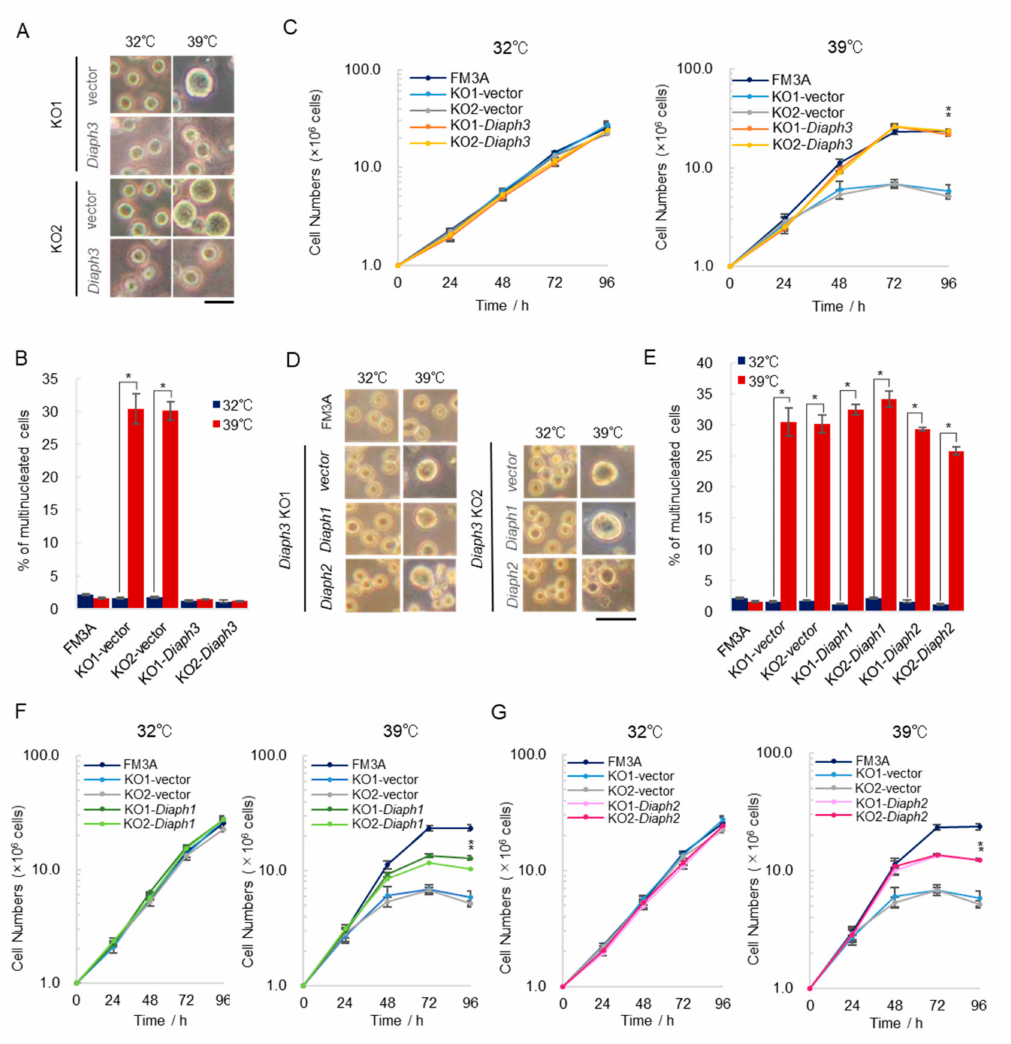
Figure 4. DIAPH3 is required for cell division only under high temperature conditions. ( A ) Cell images: Diaph3 KO1 and Diaph3 KO2 cells (KO1 and KO2) stably expressing Diaph3 were established and KO-vector and KO- Diaph3 cells were cultured for 96 h at 32 or 39 ◦ C under 5% CO 2 . The scale bar indicates 20 µ m. ( B ) Control Diaph3 -KO cells (KO-vector) and Diaph3 expressing Diaph3 -KO cells (KO- Diaph3 ) were cultured at 32 and 39 ◦ C for 24 h and were then subjected to DAPI staining. More than 300 cells were measured, and the percentage of multinucleated cells was calculated; (error bars: ± SEM); * p < 0.001 (Dunnett’s test); 32 vs. 39 ◦ C. ( C ) Growth curve analysis of KO-vector and KO- Diaph3 cells: Cells were seeded at 1.0 × 10 6 cells / dish and incubated at 32 or 39 ◦ C under 5 % CO 2 . Cells were collected every 24 h to determine the number of cells; (error bars: ± SEM); * p < 0.001 (Dunne tt’s test); KO-vector vs. KO- Diaph3. ( D ) FM3A cells, KO-vector cells, Diaph1 expressing Diaph3 -KO cells (KO- Diaph1 cells), and Diaph2 expressing Diaph3 -KO cells (KO- Diaph2 cells) were cultured for 96 h at 32 or 39 ◦ C under 5% CO 2 and photographed. The scale bar indicates 20 µ m. ( E ) FM3A, KO-vector, KO- Diaph1 , and KO- Diaph2 cells were cultured at 32 and 39 ◦ C for 24 h. The percentage of multinucleated cells was calculated as described in ( B ) (error bars: ± SEM); * p < 0.001 (Dunnett’s test); 32 vs. 39 ◦ C. ( F ) Growth curve analysis of FM3A cells, KO-vector cells, and KO- Diaph1 cells was performed as described in ( C ); (error bars: ± SEM); * p < 0.001 (Dunnett’s test); KO-vector vs. KO- Diaph1 . ( G ) Growth curve analysis of FM3A cells, KO-vector cells, and KO- Diaph2 cells was performed as described in ( F